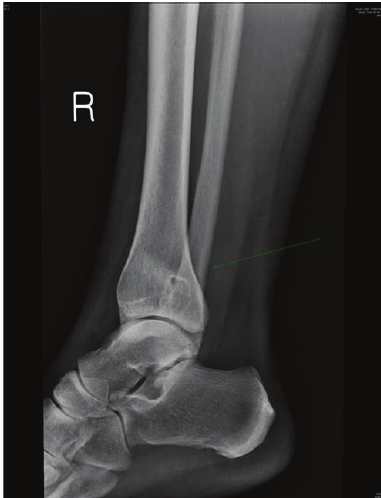
Figure 3: Lateral view X-ray showing reoccurring cystic lesion in distal tibia.